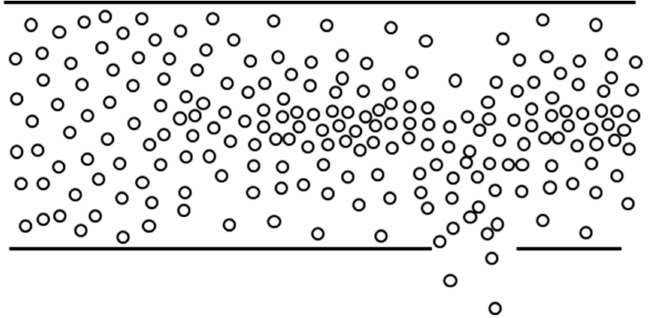
Figure 3. Schematic view of the process considered in this study; please note the change in concentration profile close to the pore that will be discussed in detail in the results